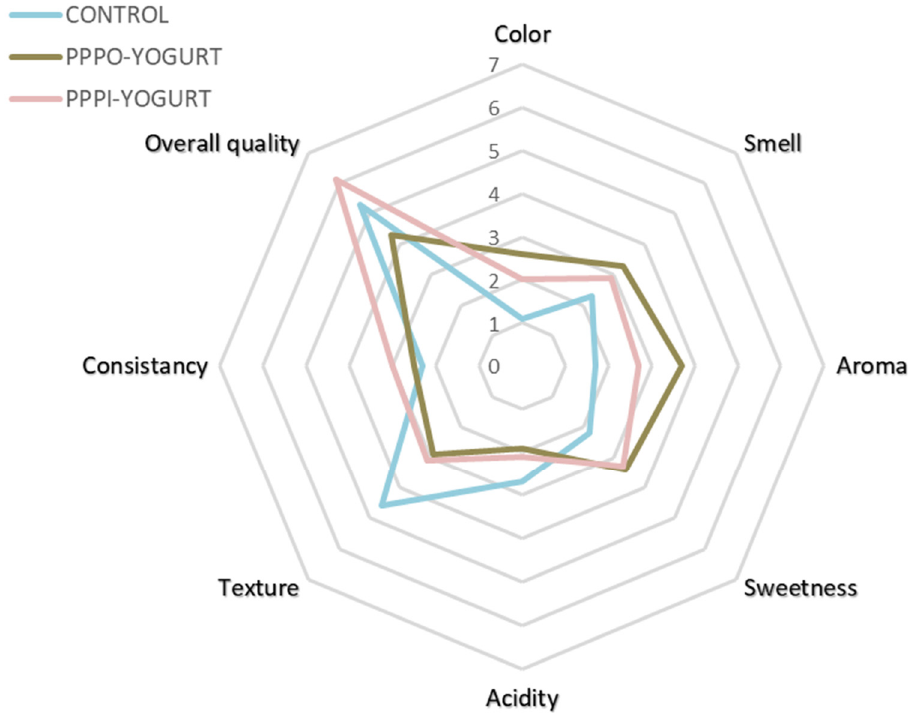
Figure 3. Spider graphs of the sensory profile of the formulated yogurt samples. PPP-YOGURT: yogurt fortified with potato peel powder, PPI-YOGURT: yogurt fortified with potato peel pieces.